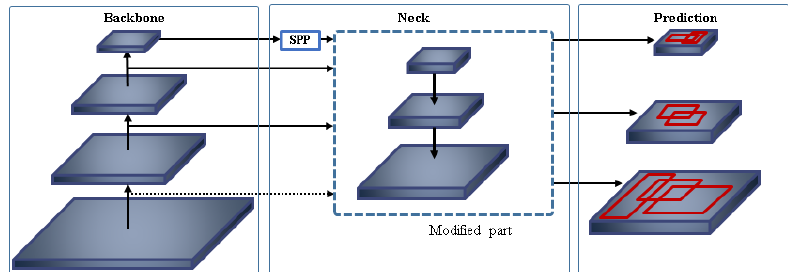
Figure 6. The network architecture of YOLOv3.